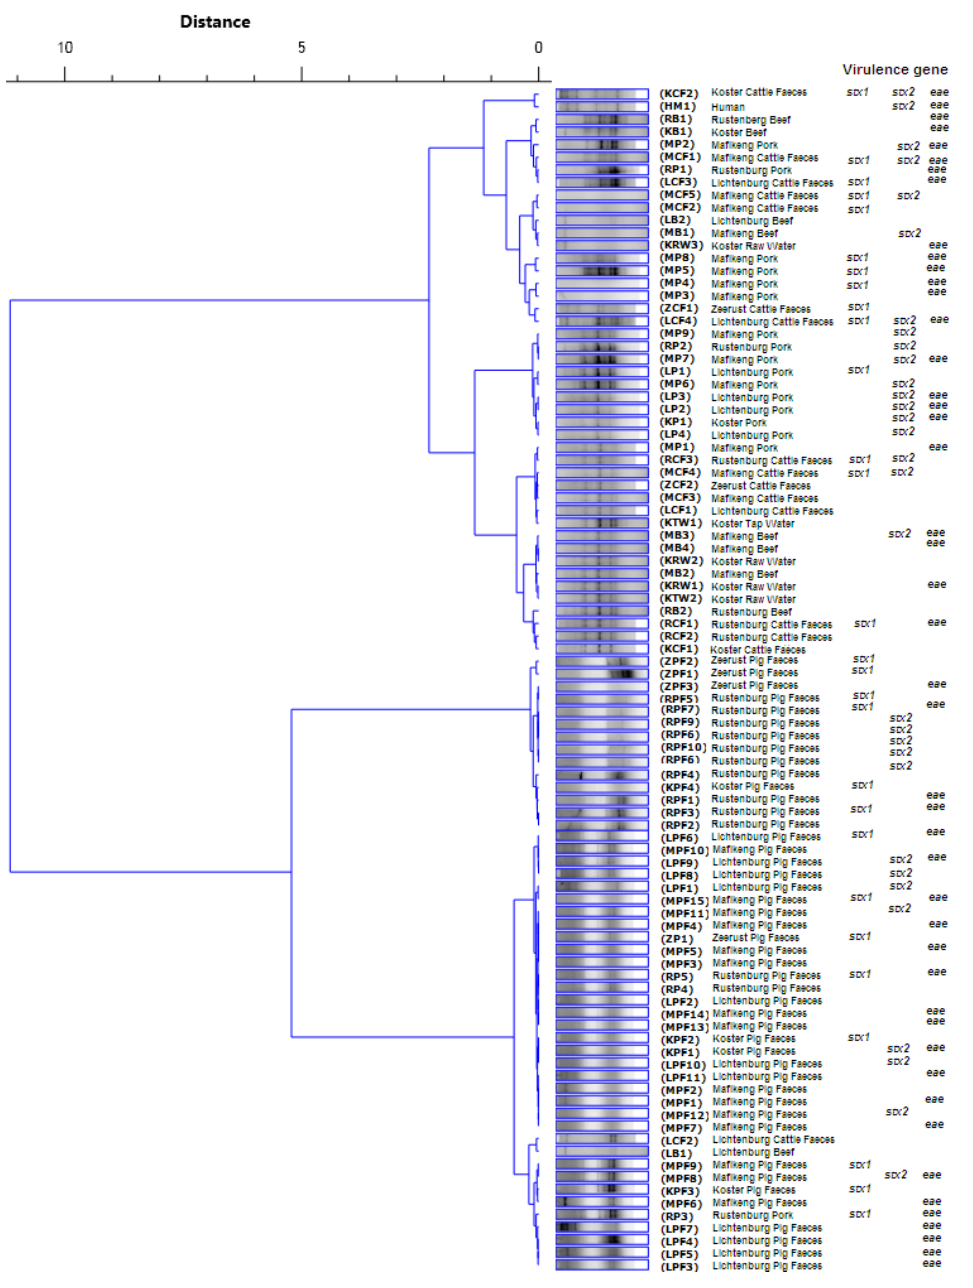
Figure 2. Dendrogram showing the relationship of E. coli O157:H7 isolated using the ERIC PCR